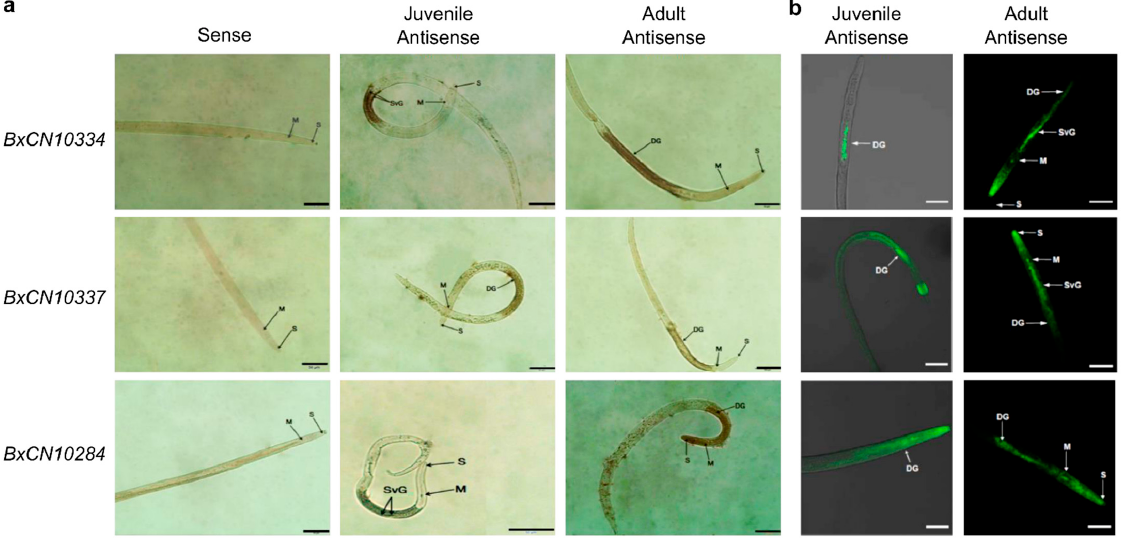
Figure 5. Localization of three BxCN legumain transcripts in the nematode by in situ hybridization: ( a ) hybridization with digoxigenin-labelled cDNA probes. Scale bar, 50 μ m; ( b ) hybridization with 5 ′ - end FITC-labelled cDNA probes. DG, dorsal glands; M, median bulb; S, stylet; SVG, subventral glands. Scale bar, 20 µ m.